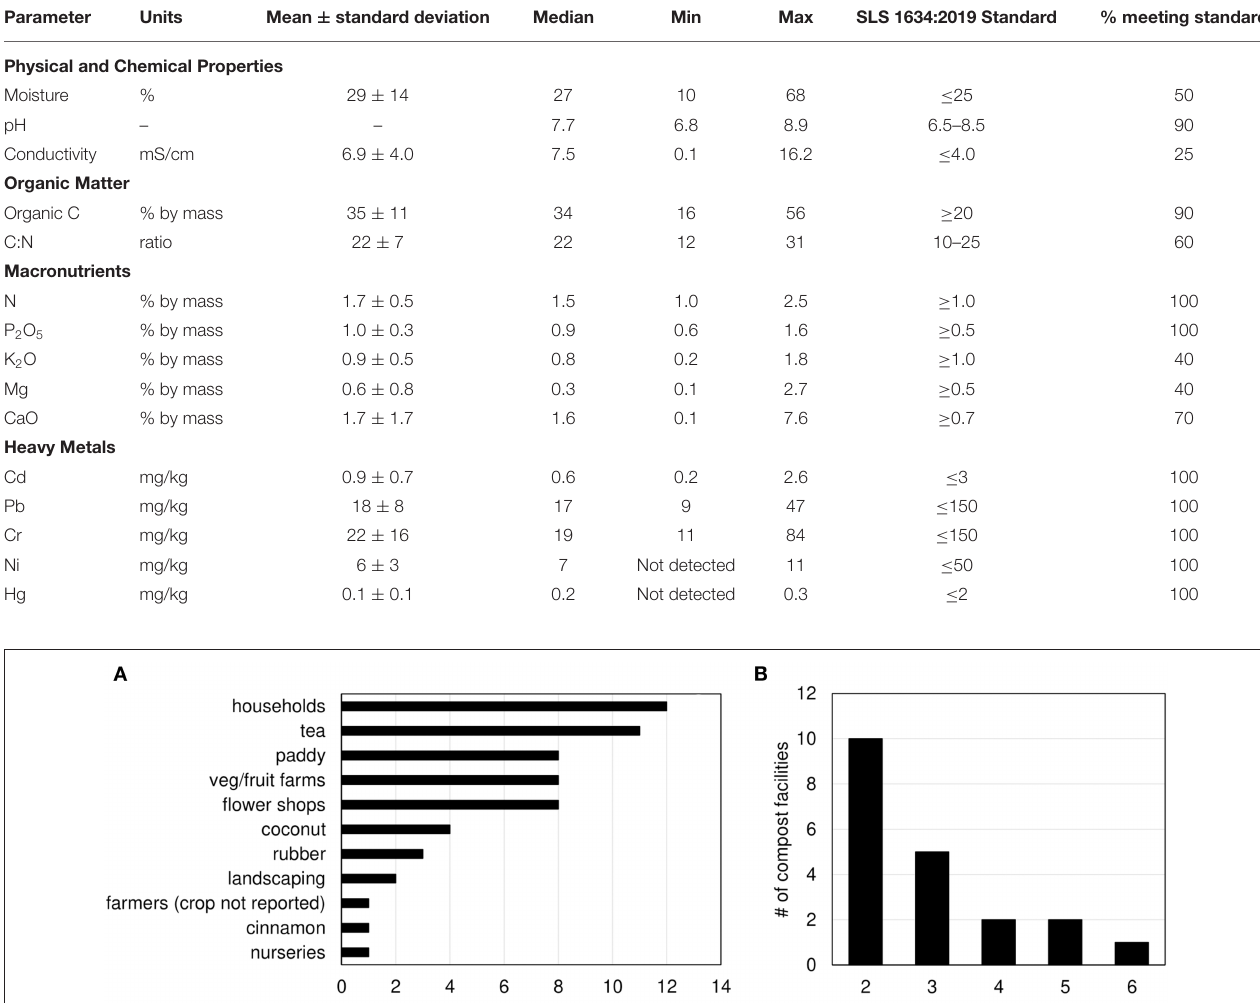
TABLE 2 | Compost quality parameters for samples collected from MSW composting facilities in Sri Lanka ( n = 20) compared to the SLS 1634:2019 Standards (Sri Lanka Standards Institution,